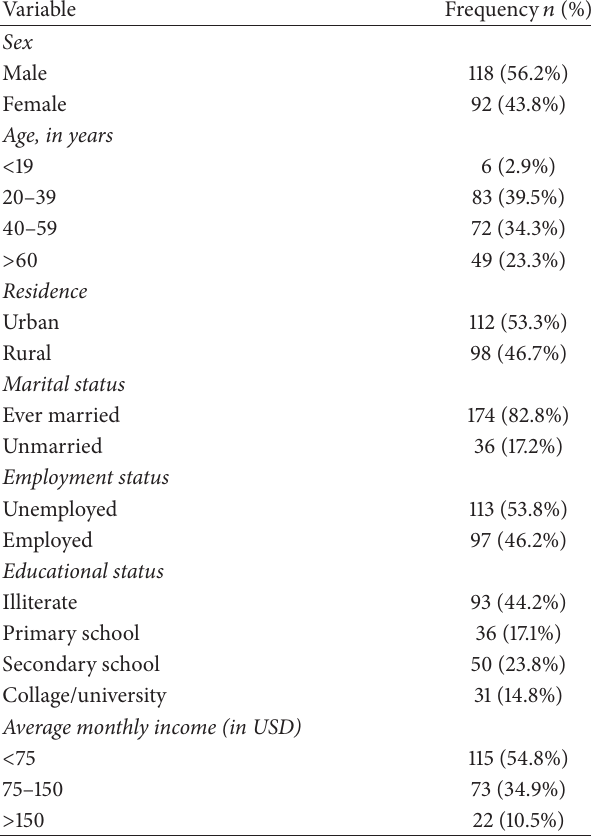
Table 2: Disease and treatment characteristics of respondents ( 𝑛 = 210